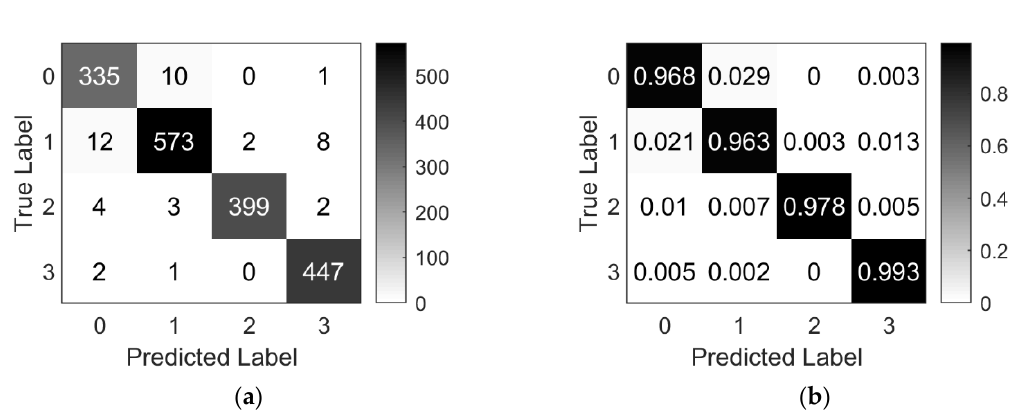
Figure 15. Confusion matrix and its normalization of the proposed method using the self-built dataset. Notes: Numbers 0, 1, 2, and 3 correspond to the bulk, container, passenger, and sailing ship types; ( a ) confusion matrix; and ( b ) confusion matrix